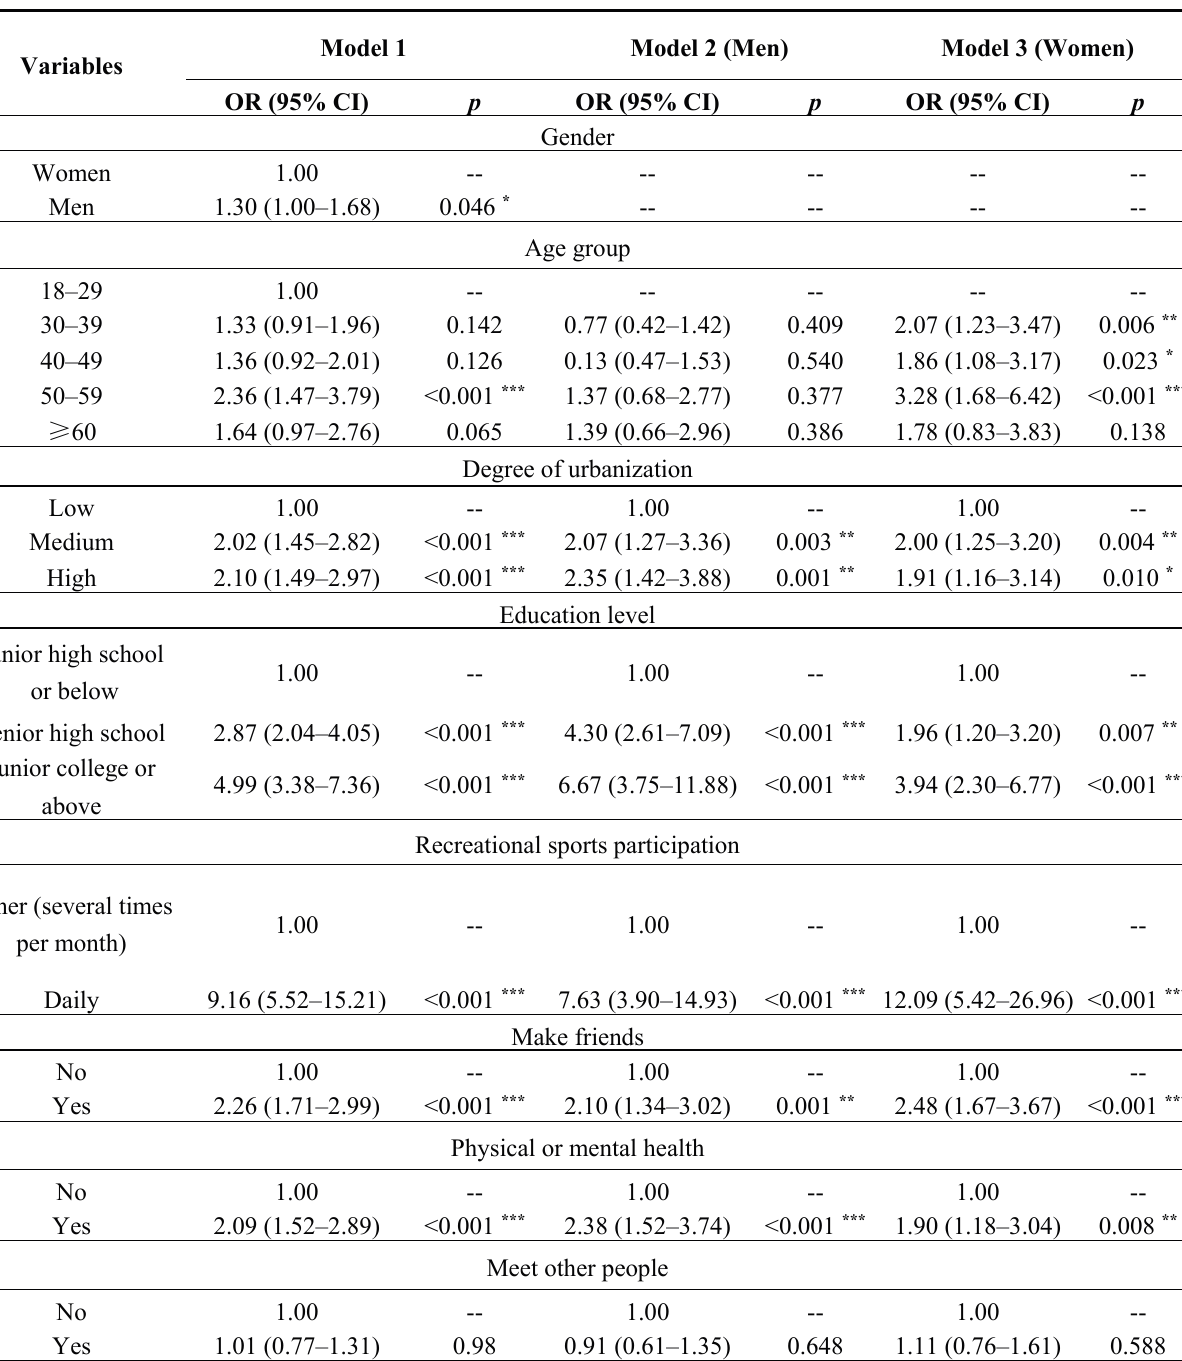
Table 3. Multiple logistic regressions of the odds ratios with a 95% confidence interval for recreational sports among adults in